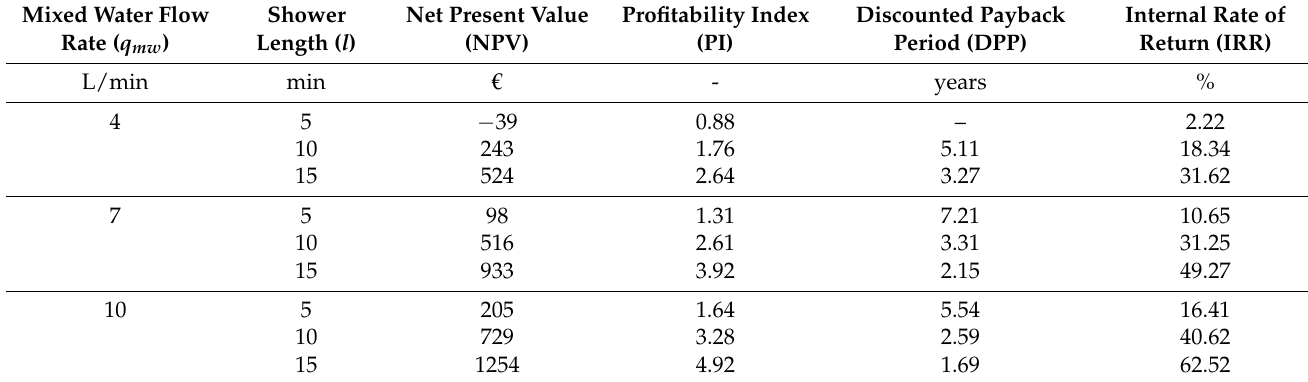
Table 4. Summary of the calculation results for an electric water